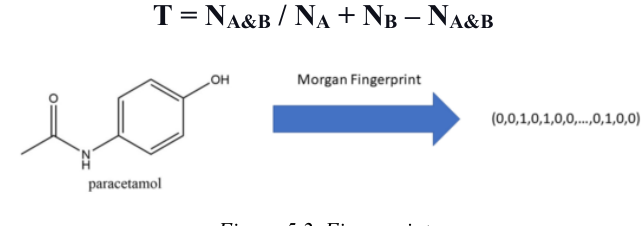
Figure 5.2. Fingerprint